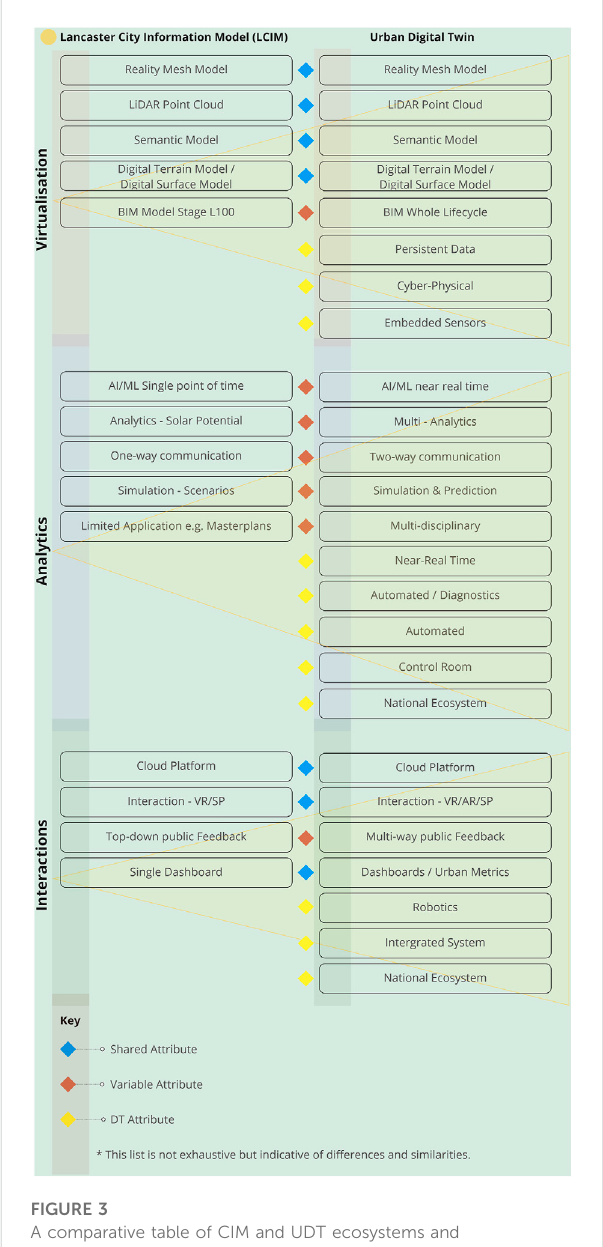
FIGURE 3 A comparative table of CIM and UDT ecosystems and